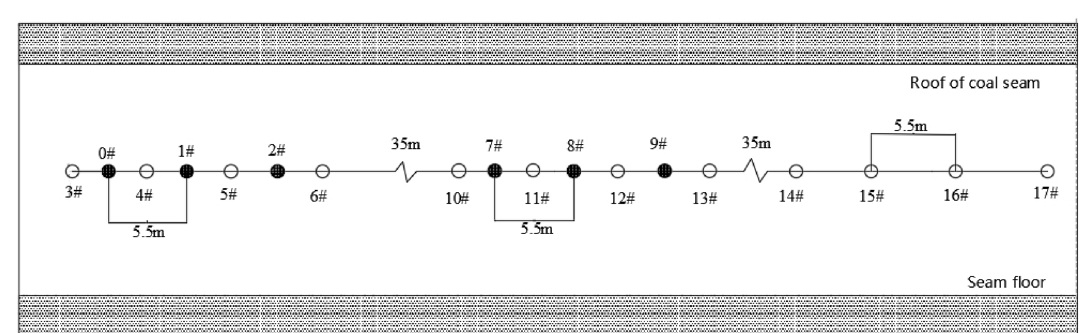
Figure 8. Gas pressure change curves of pressure taps.